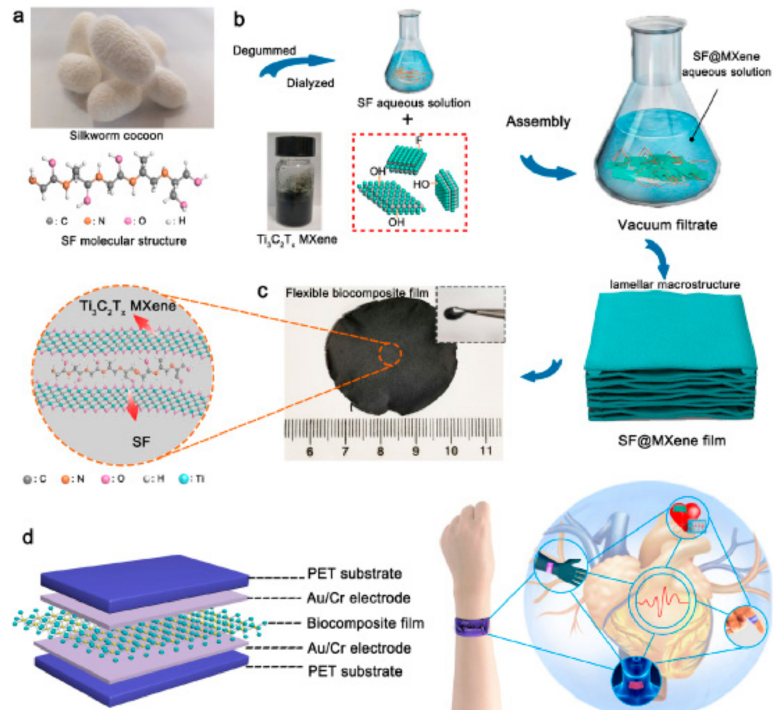
Figure 2. Preparation of the MXene-based bionanocomposite as a flexible pressure sensor. ( a ) Image of a silkworm cocoon with structure of a silk fibroin (SF) on a molecular level. ( b ) The fabrication of SF@MXene bionanocomposite film. ( c ) Image of SF@MXene bionanocomposite film. Inset shows SF@MXene bionanocomposite film on a molecular level. ( d ) Scheme of SF@MXene bionanocomposite film-based sensor applicable for monitoring of human health (right). Reprinted from ref. [16], Copyright (2020), with permission from